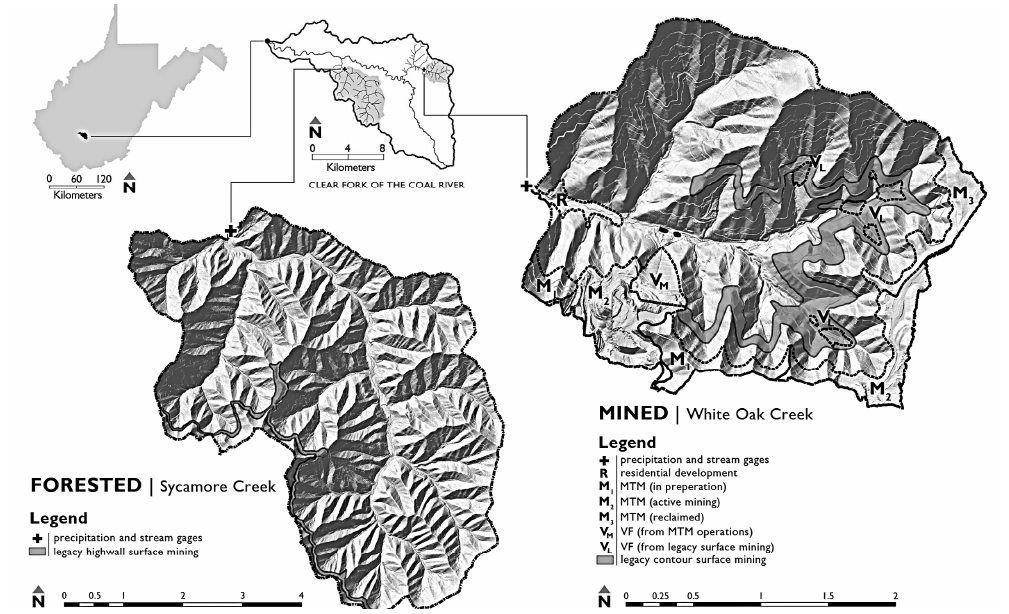
Figure 2. Location of the mountaintop mined White Oak Creek catchment and the forested Sycamore Creek catchment in the southern West Virginia Coalfields region. Hillshade and catchment boundaries were derived from a 1-m LiDAR DEM flown and processed by West Virginia University Natural Resource Analysis Center in April of 2010. Land use boundaries were digitized from 1-m aerial imagery from the 2011 National Agriculture Imagery Program